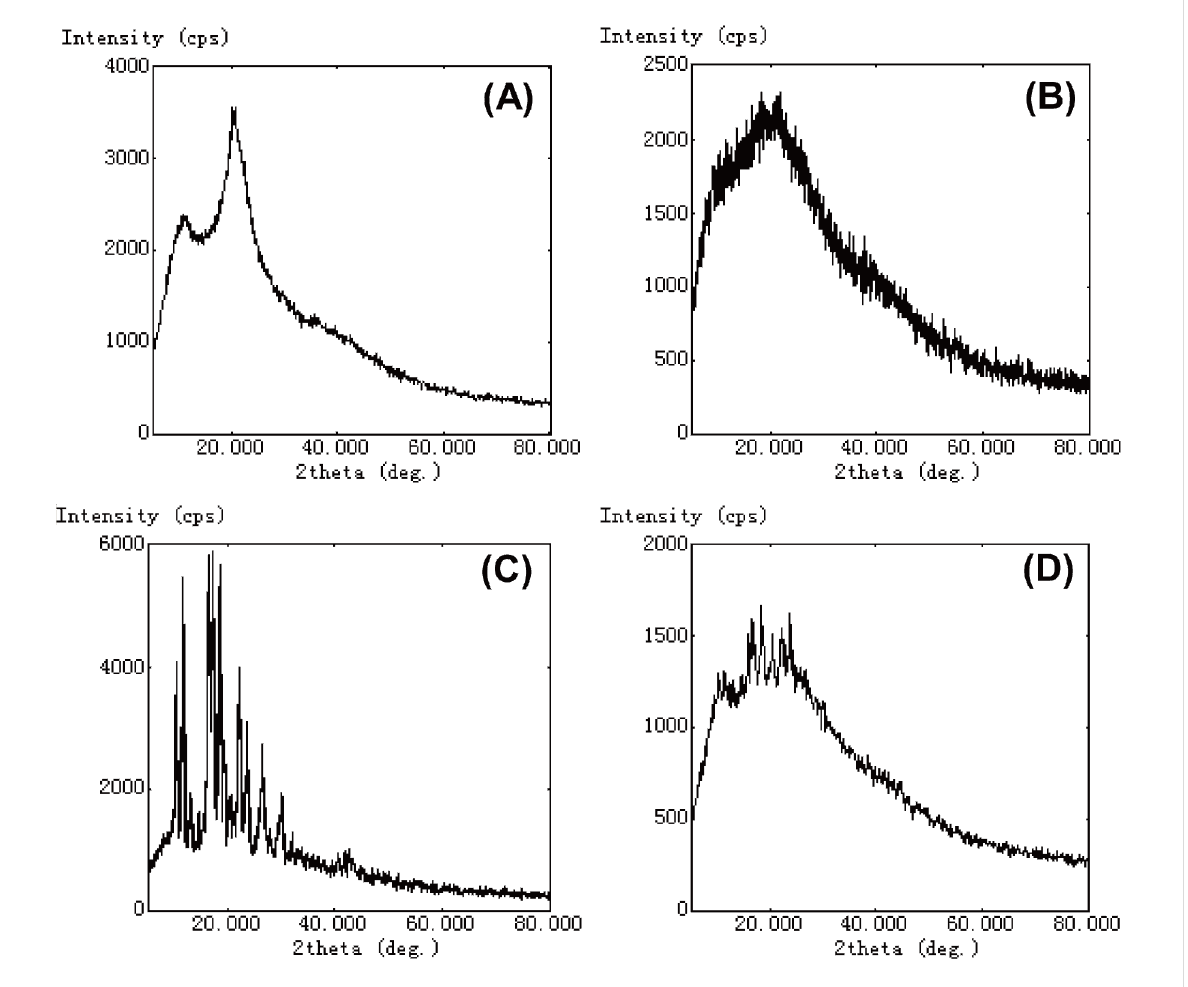
Figure 4: XRD spectra of (A) Cs, (B) blank CNs, (C) MIF, and (D) MCNs. The XRD analysis of MCNs showed the detailed peaks of MIF superim- posed over the amorphous features of